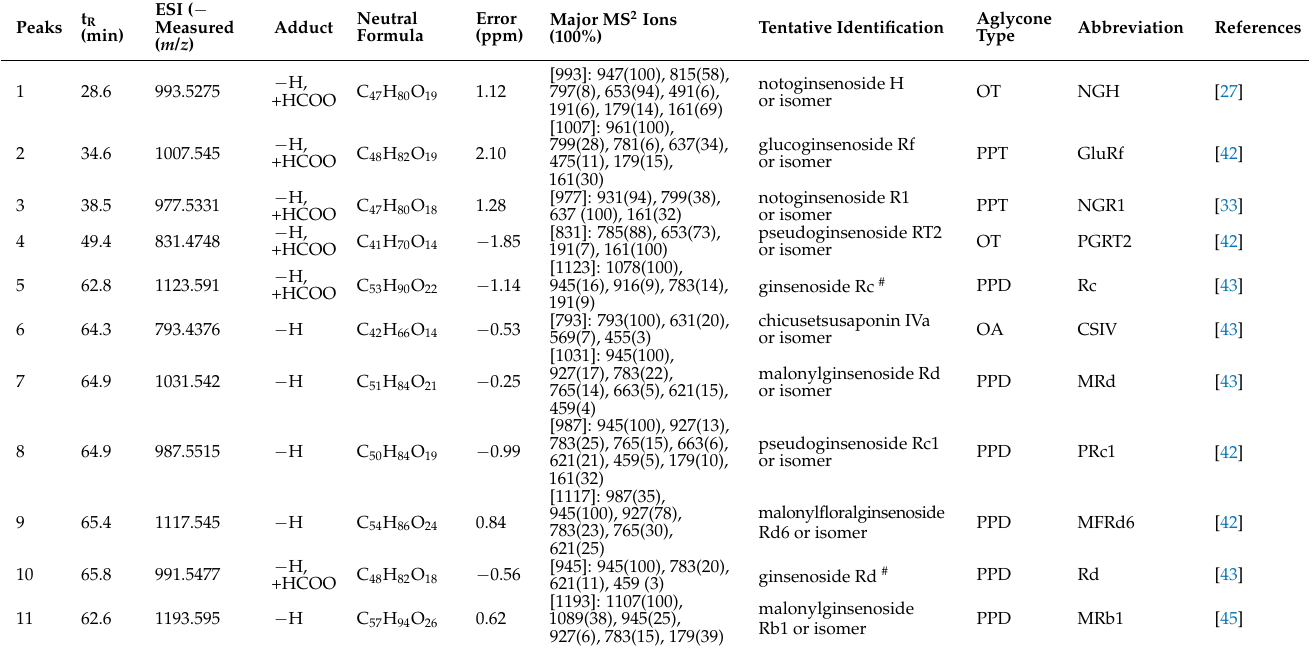
Table 1. Discriminative ginsenosides tentatively identified between cultivated and wild